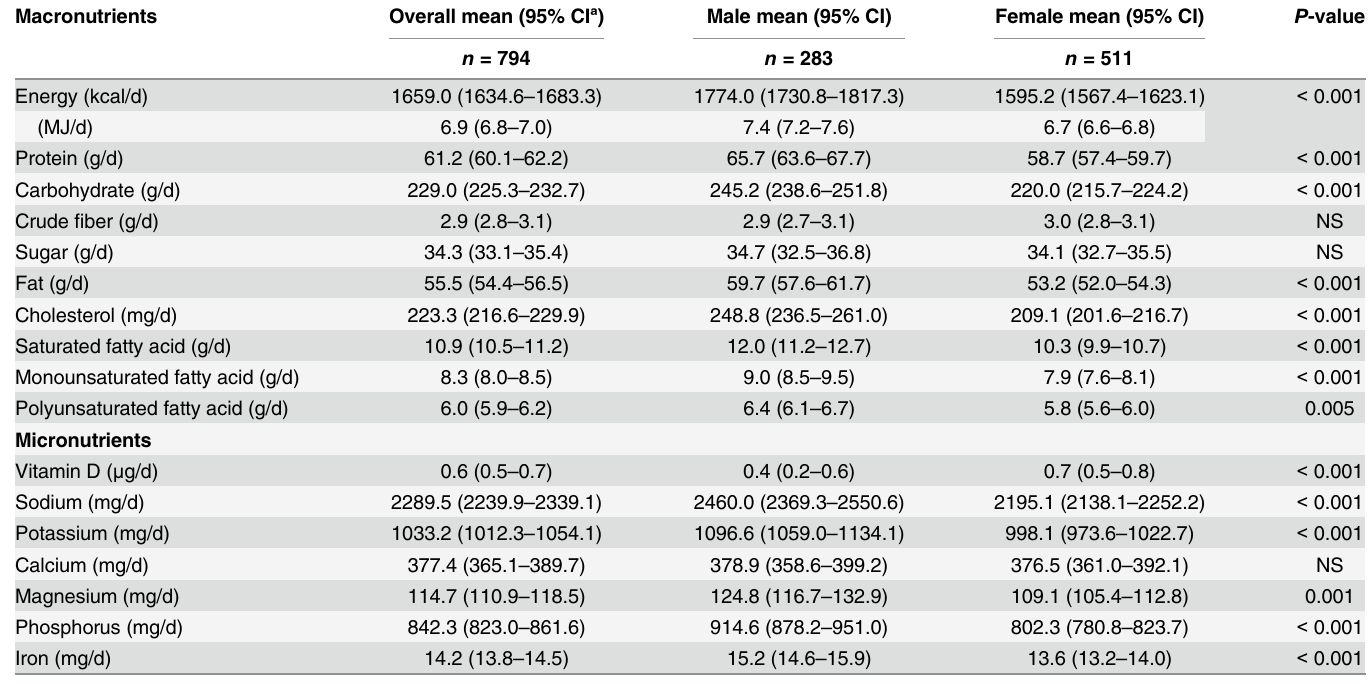
Table 2. 7-d nutrient intake for adolescents age 13-y-old attending secondary schools by